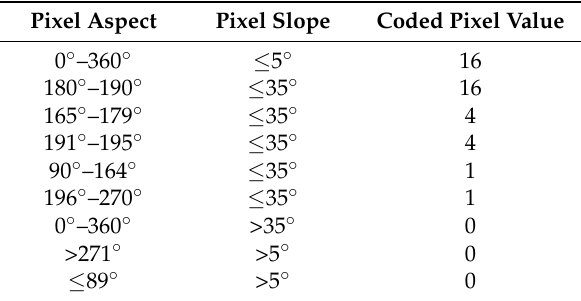
Table 1. Pixel coding structure for solar